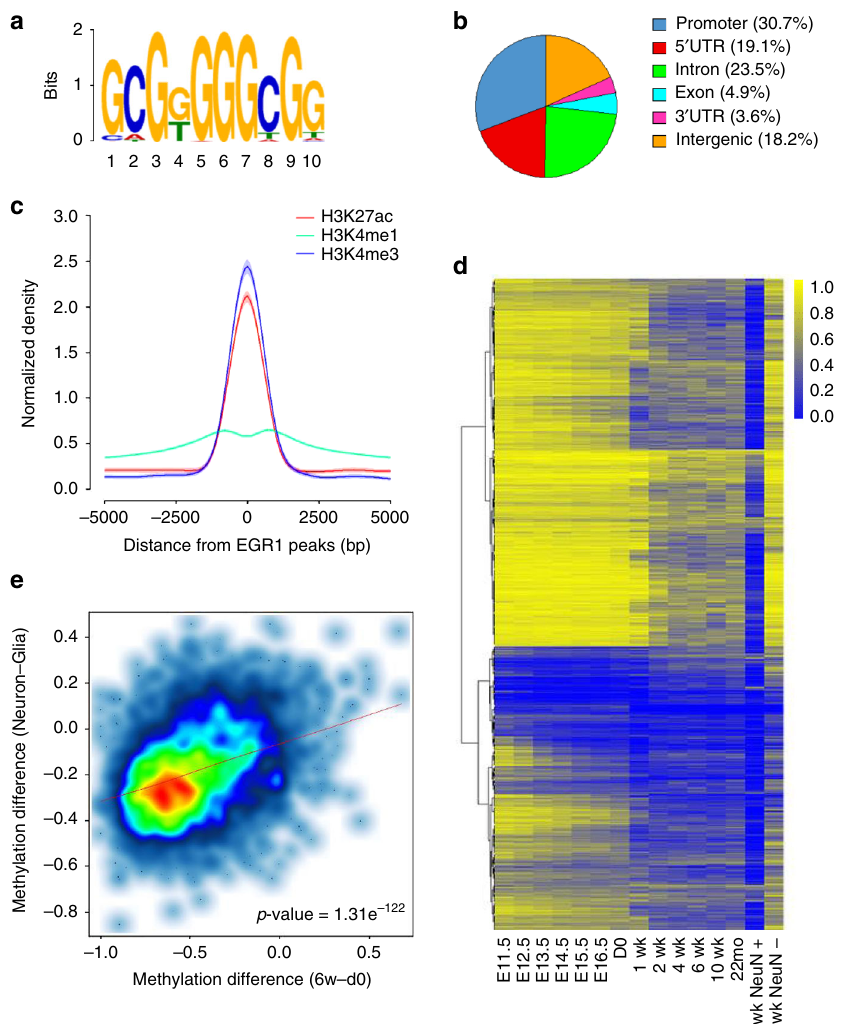
Fig. 1 Methylation dynamics of EGR1 binding sites during mouse brain development. a EGR1 binding motif ( E value = 1.1e − 252 ) identi fi ed from ChIP-seq data generated with mouse adult frontal cortices. b Genomic distribution of EGR1 peaks. c Distribution of histone marks H3K27ac, H3K4me1, and H3K4me3 surrounding EGR1 peaks. d Methylation dynamics of EGR1 binding sites during brain development from embryonic day 11.5 to 22 months, in neurons (NeuN + ), and non-neuronal cells (NeuN − ). e Correlation of methylation changes at EGR1 binding sites during mouse brain development and between cell speci fi cation. Only binding sites with at least ten methylation calls in all four methylomes were included. P -values were determined